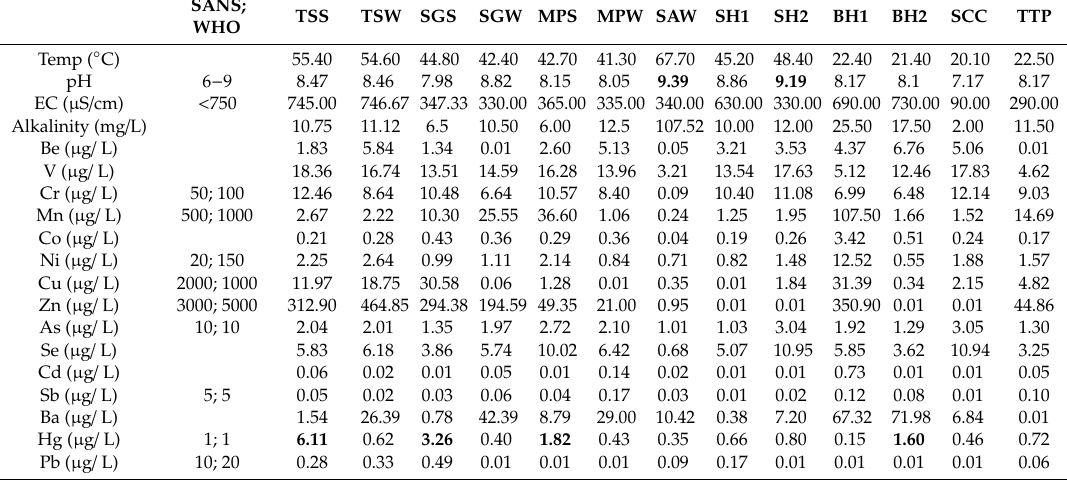
Table 4. Mean physicochemical parameters and trace metal concentrations of the geothermal springs and boreholes within